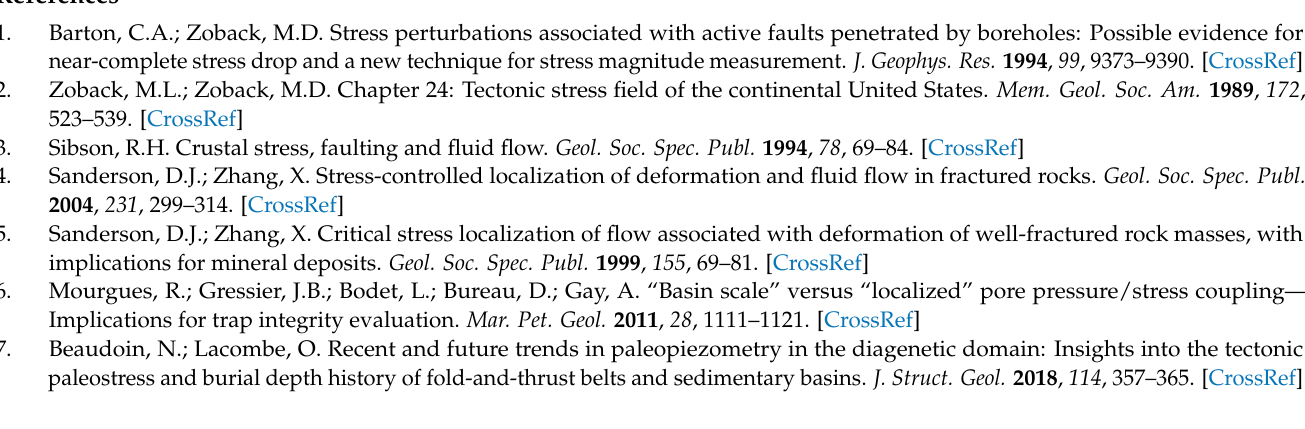
samples, Table S2: GPS coordinates of measurement and sampling sites, Figure S3: interpretated X-ray diffractometry spectrum of the Scaglia Rossa, Figure S4: ∆ 47 analysis report, detailing analysis and